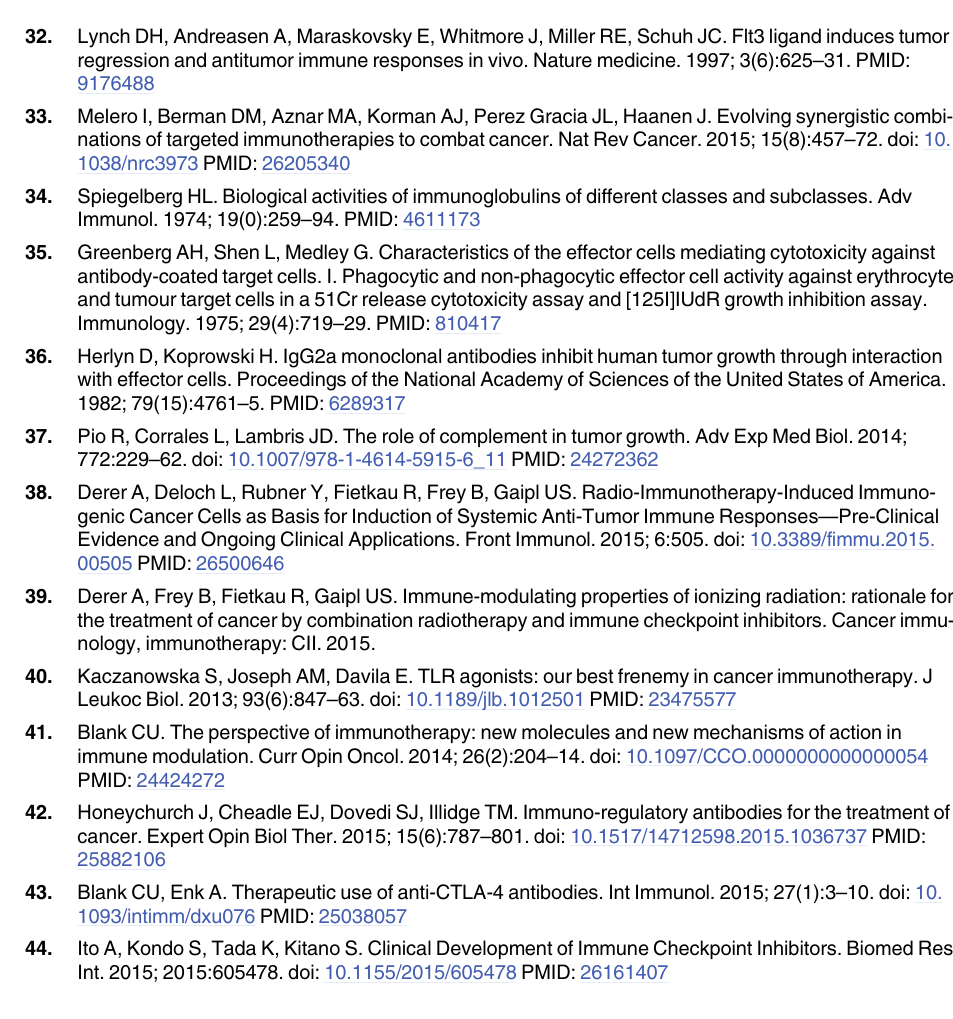
PLOS ONE | DOI:10.1371/journal.pone.0159515 July 18,